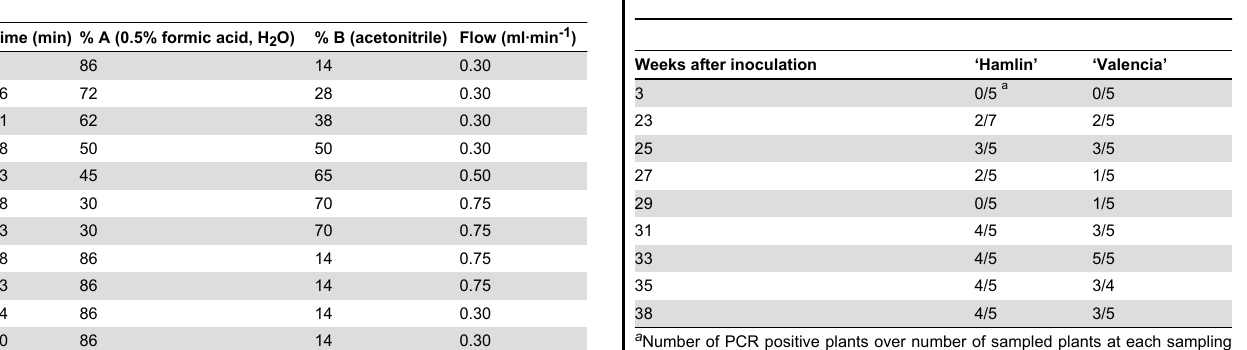
Table 1. Mobile phase composition and flow rate. Table 2. PCR results for inoculated ‘Hamlin’ and ‘Valencia’